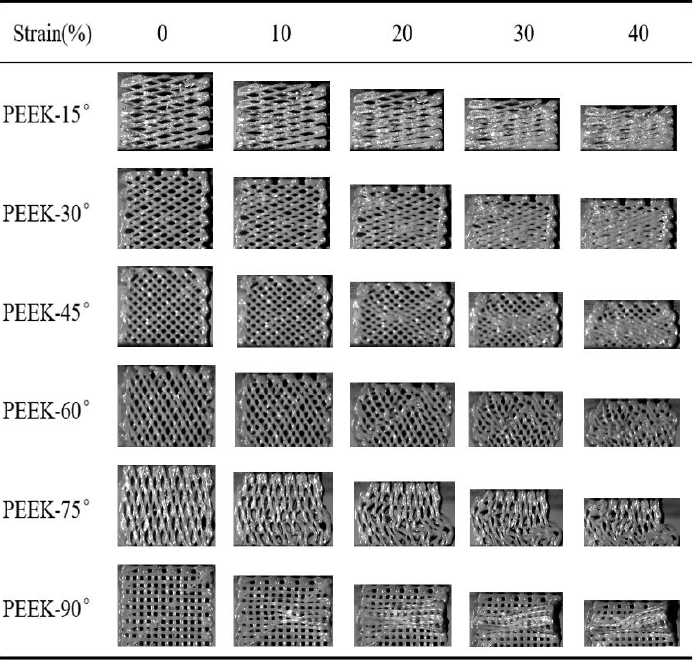
Figure 5. The compressive process of the pure PEEK scaffolds with different raster angles.